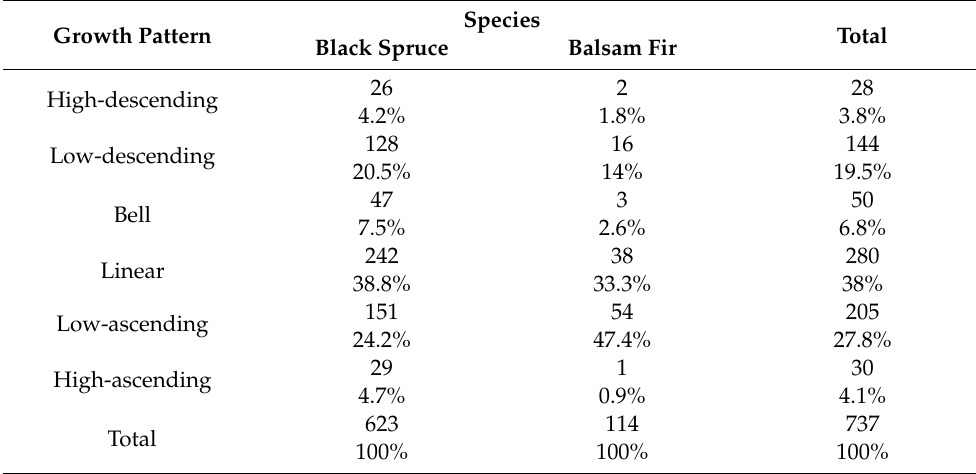
Table 1. Absolute and relative frequency of black spruce and balsam fir growth patterns. χ 2 : chi-square value, df: degrees of freedom.